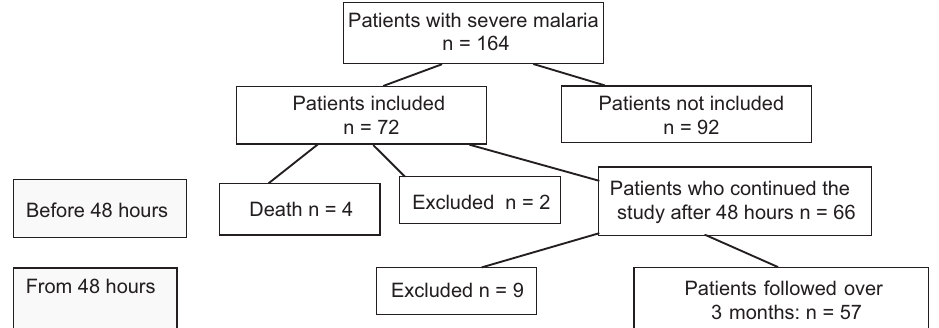
Figure 1: Flow diagram of patients with severe malaria at the Borgou Departmental Teaching Hospital included in the study in